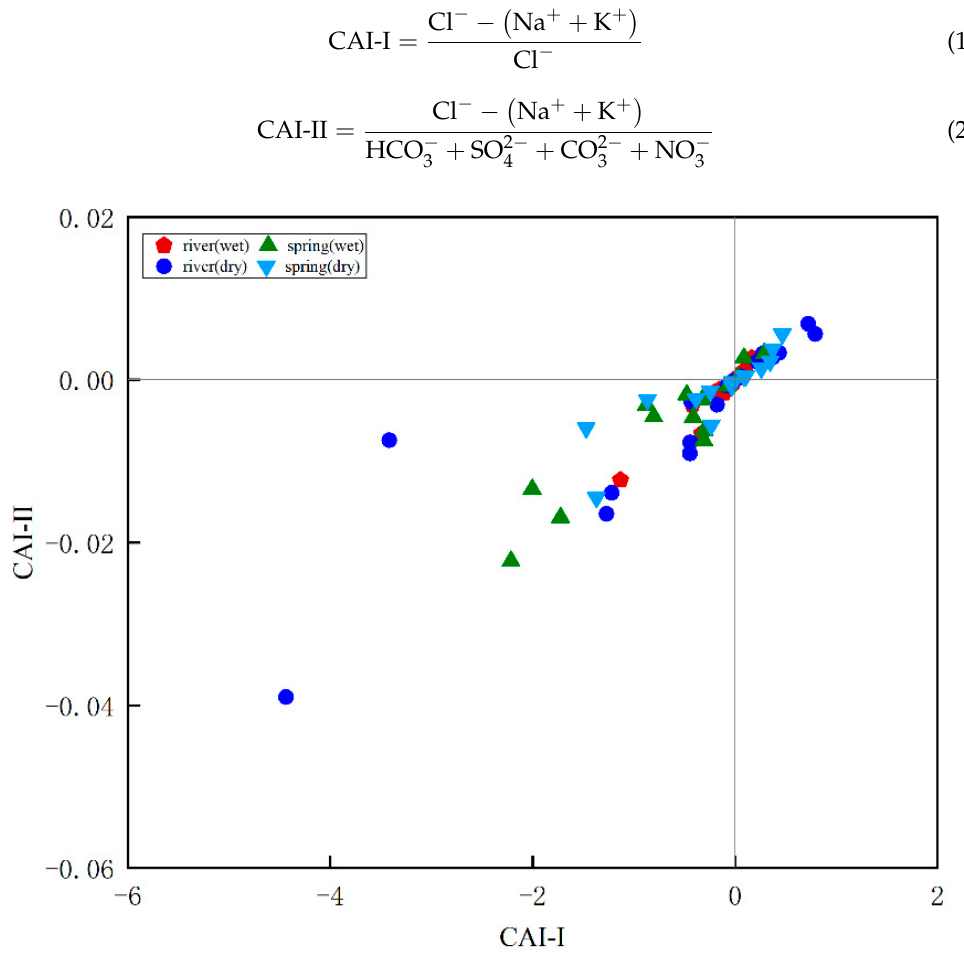
Figure 7. Diagram of chloro-alkaline indices.